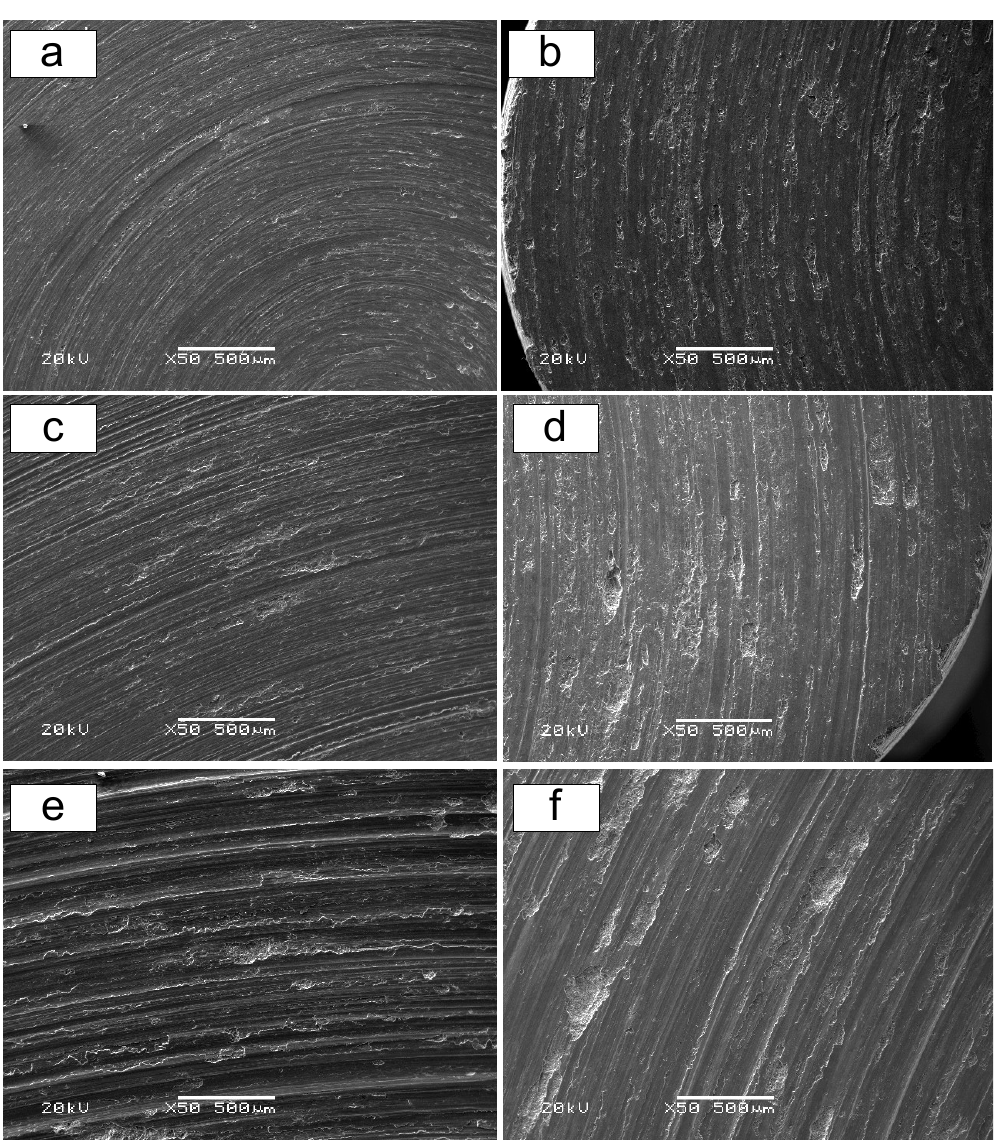
Figure 5. Scanning electron micrographs of worn surfaces under a load of 5 N and sliding velocities from 0.25 to 1.0 m/s. ( a , c , e ) Worn surfaces of Al–12Si–CuNiMg matrix alloy at 0.25, 0.50, and 1.0 m/s, respectively. ( b , d , f ) Worn surfaces of Al 2 O 3 fiber-reinforced composite at 0.25, 0.50, and 1.0 m/s,